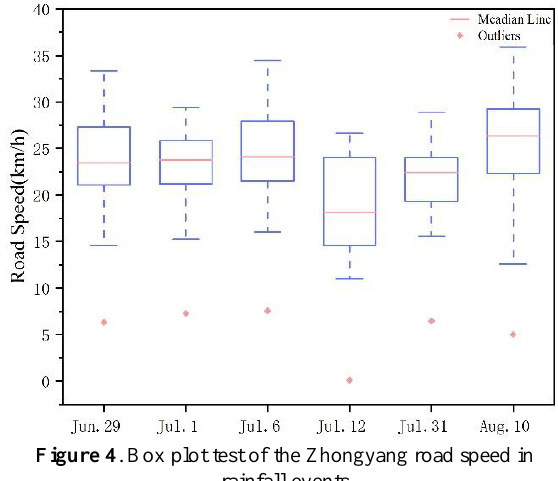
Figure 4 . Box plot test of the Zhongyang road speed in rainfall